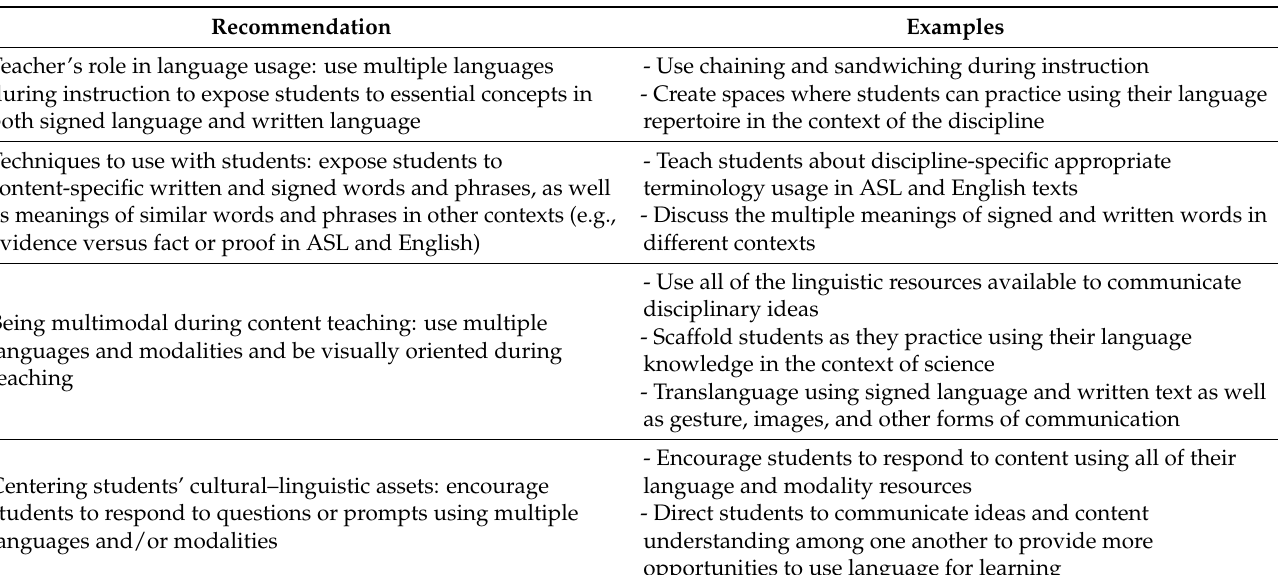
Table 1. Recommendations for translanguaging practices in disciplinary content areas with examples of how these practices can be